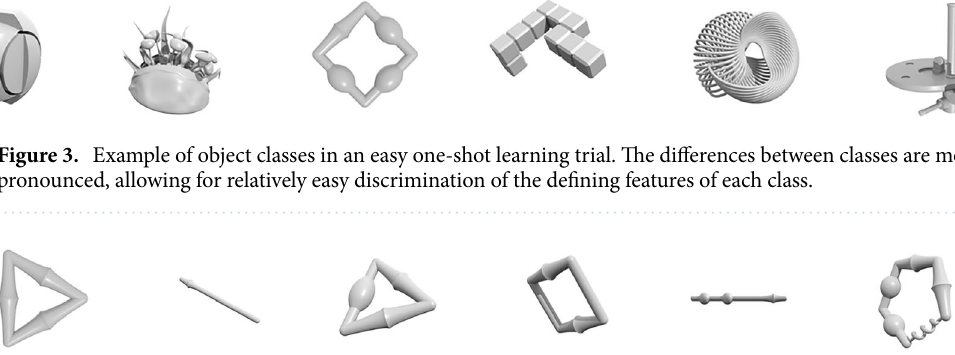
Figure 4. Example of object classes in a hard one-shot learning trial. The differences between classes are less pronounced, demanding greater attention and thought about the defining features of each